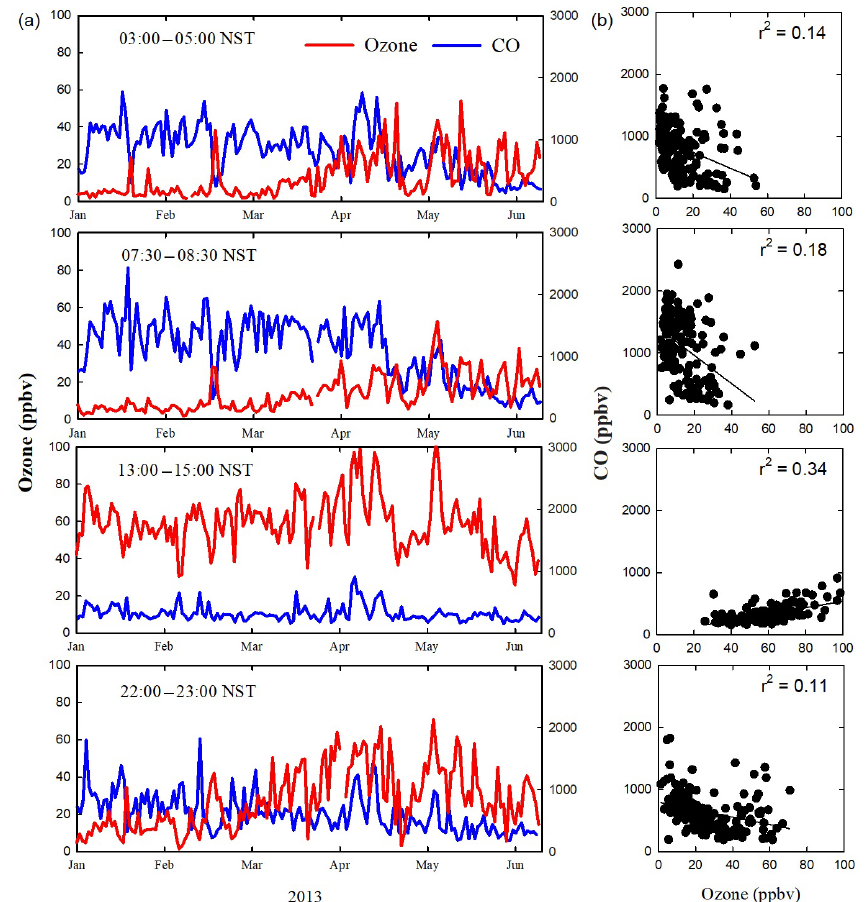
Figure 10. (a) Variations in ozone and CO during four time periods at Bode, Nepal. Correlation among them is also shown (b)